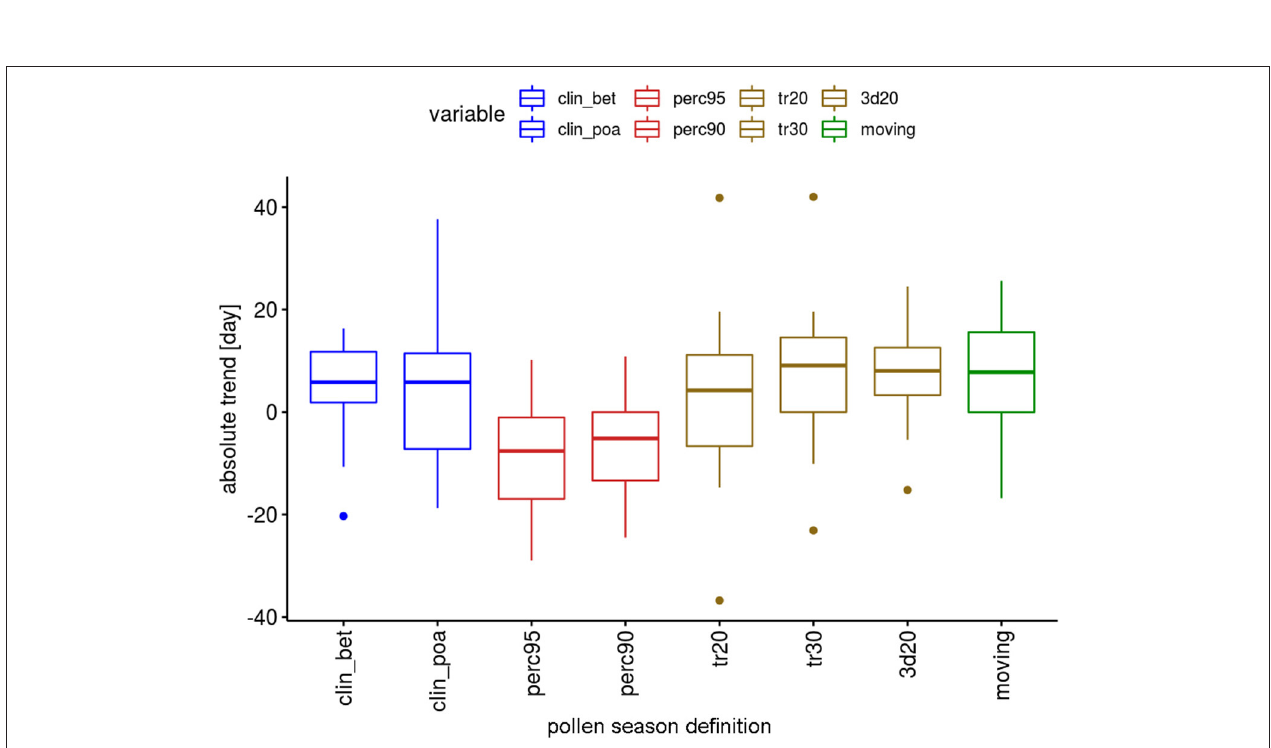
FIGURE 6 | Range of absolute trends [days] for the 50-year period 1969–2018 of the duration of the pollen season by definition for 12 pollen taxa.